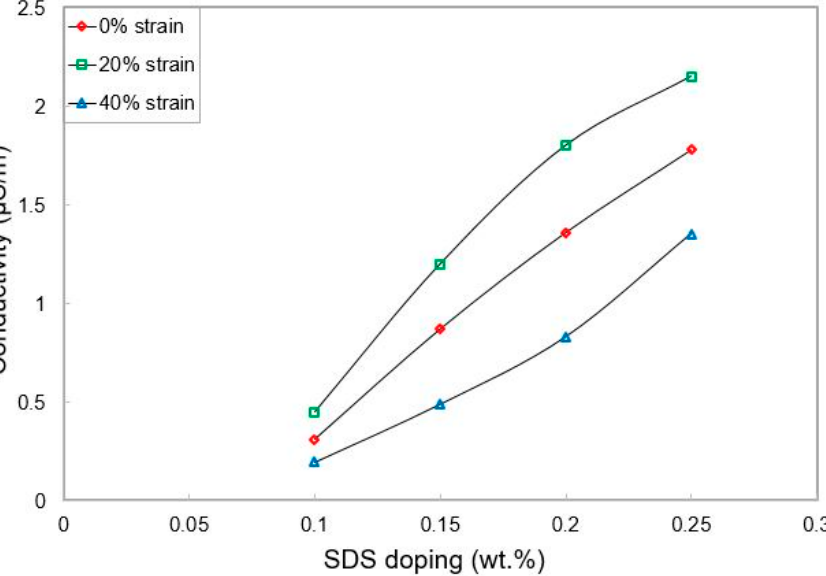
Figure 5. Response of the sensors to the change in conductivity with respect to strain.